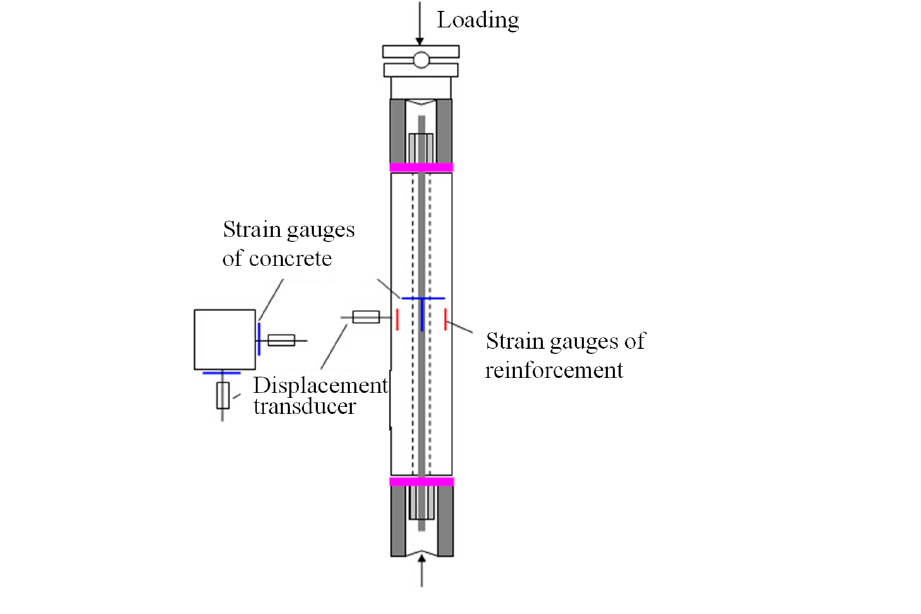
Figure 4. Configuration of loading test.